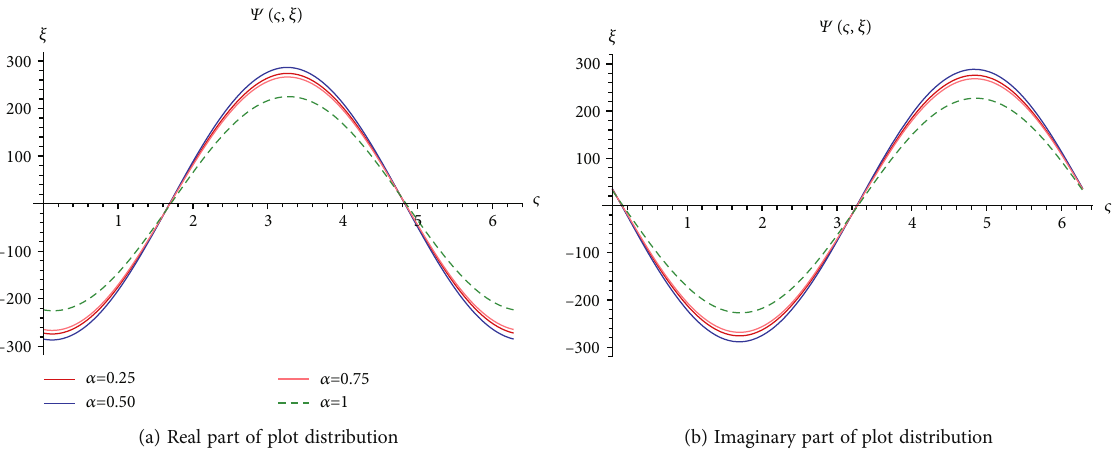
Figure 1: Surface solution of Equation (13) when α = 1 .